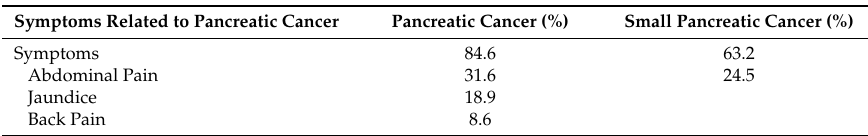
Table 1. The Pancreatic Cancer Registry Report of Japan 2007.